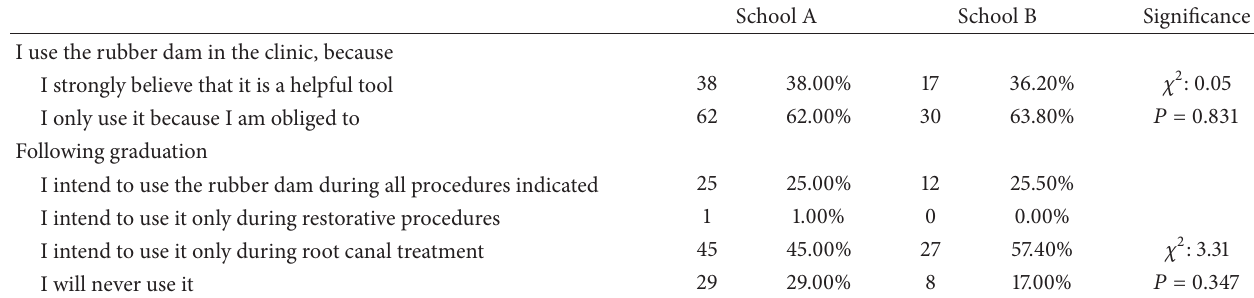
Table 5: Opinion of students about the present and future usage of rubber